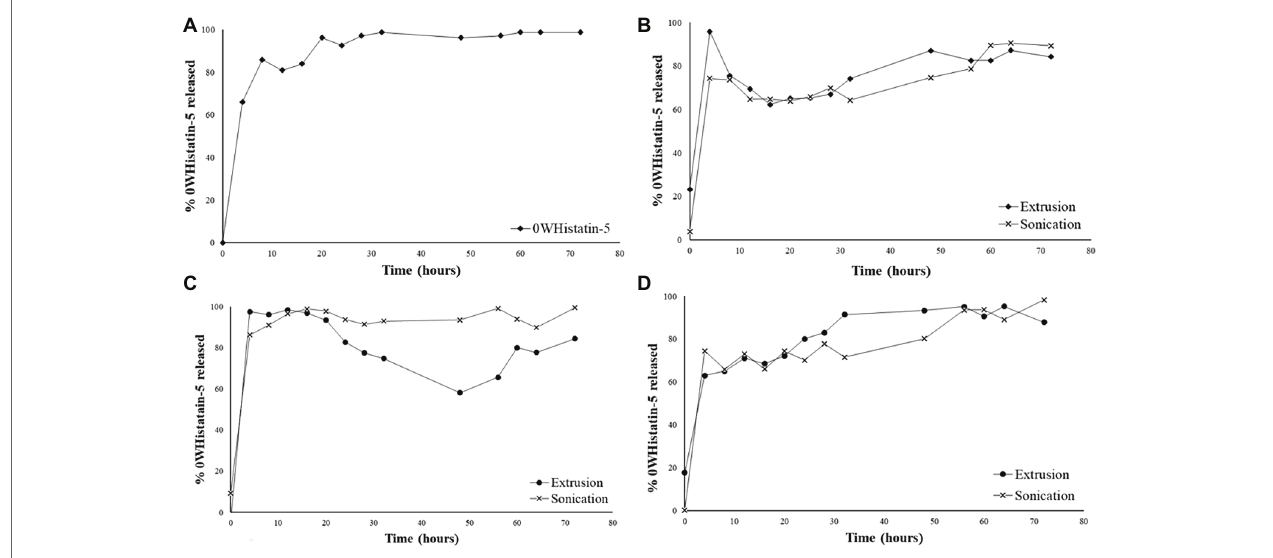
FIGURE 4 | Release profile for: free 0WHistatin 5 (A) ; F1 (B) ; F2 (C) ; and F3 (D) , loaded with 0WHistatin